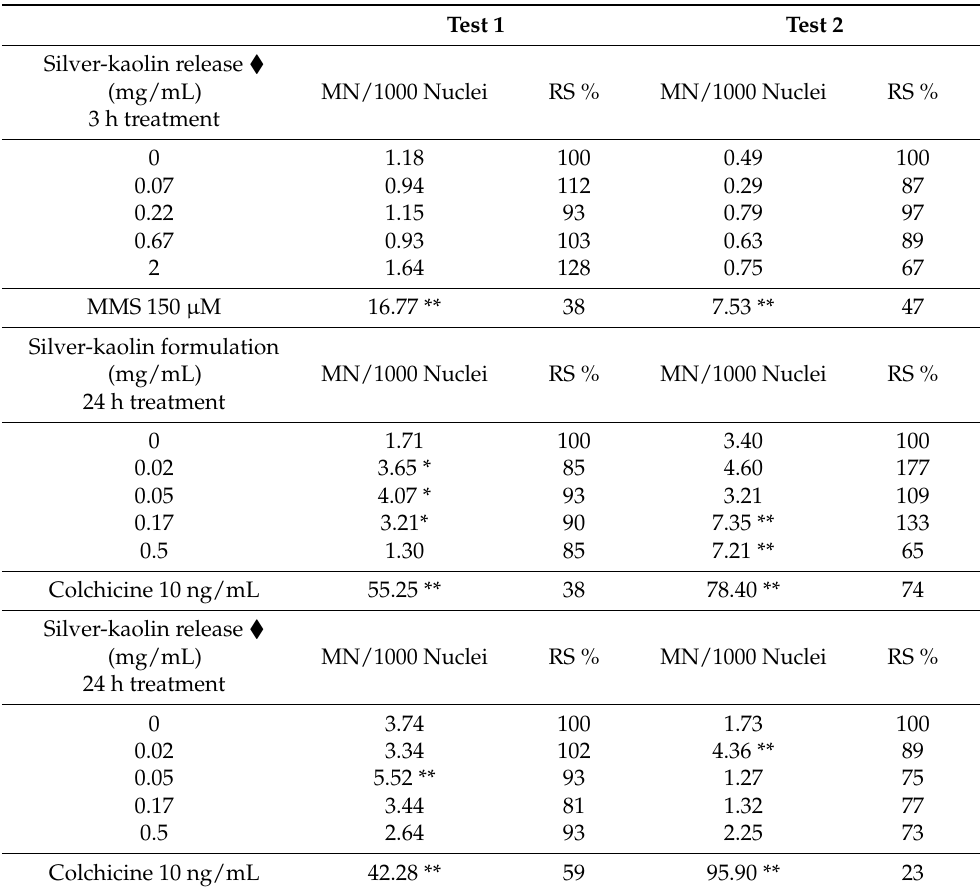
Table 1. Results of the MN tests. The results of two independent experiments are represented in each case as MN/1000 Nuclei and RS %. Statistically significant difference from negative control *: ( p < 0.05), **: ( p < 0.01). Test 1 Test 2 Silver-kaolin release (cid:7)